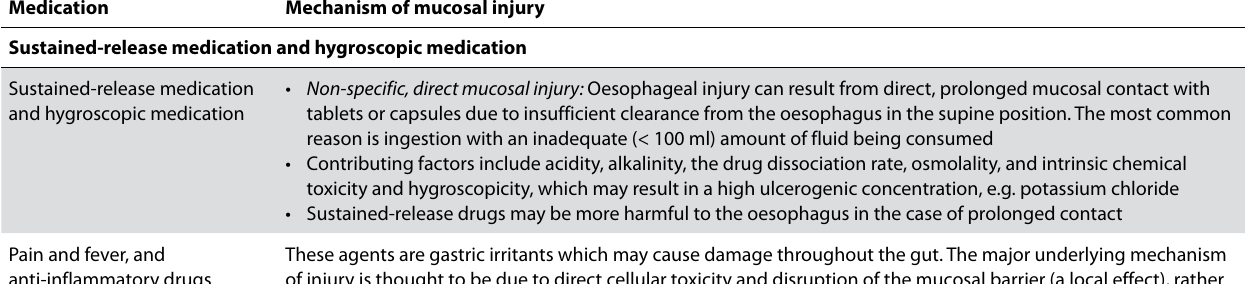
Medication Mechanism of mucosal injury Sustained-release medication and hygroscopic medication Sustained-release medication and hygroscopic medication